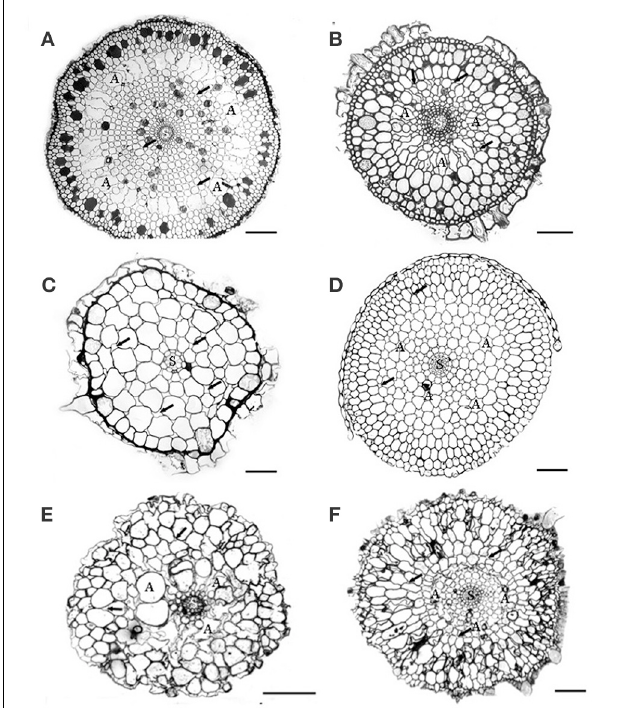
FIGURE 1 | Cross-sections of 6 Australian seagrasses. (modified from Cambridge et al., 2012) (A) Cymodocea sp.: The epidermis is distinct. Hypodermis with thickened walled cells. Outer cortex with 3–4 layers of large cells containing tannin substances. Middle cortex with many regular large lacunae (A). Small intercellular spaces (arrows) occur in the inner cortical tissue. The stele is distinct. Scale bar = 100 μ m. (B) Syringodium isoetifolium : Epidermal cells large, with tannin substances. Hypodermal cells small with thickened walls. Outer cortex with 3–4 layers of large cells, middle cortex with many developing regular large lacunae (A). Small air spaces (arrows) occur in both middle and inner cortical tissue. The stele (S) is distinct. Scale bar = 100 μ m. (C) Halodule uninervis : Epidermal cells large. Small hypodermal cells with thicken walled. Cortex does not have distinct regions and consists of 5–6 layers of cortical cells with the outer ones being the largest. Distinct intercellular spaces occur throughout the cortical tissues. The central stele (s) is small. Scale bar = 100 μ m. (D) Halophila ovalis : This section was taken from the basal portion of the root, where root hairs were absent. Epidermal cells small, hypodermal cells with thickened walls. Distinct lacunae (A) occur in the mid cortex region. The intercellular spaces (arrows) occur in both middle and inner cortical tissues. The stele (S) is distinct. Scale bar = 150 μ m. (E) Posidonia australis : Branched root shown: cortical tissue only has about 8–10 cell layers, without distinct regions. Air lacunae (A) are developing. Few intercellular air spaces (arrows) are present. Scale bar = 100 μ m. In developing “white” roots, epidermal cells are distinct, 1–2 layers of hypodermis and many distinct air lacunae in the middle cortex. Scale bar = 100 μ m. (F) Amphibolis Antarctica : Both epidermis and hypodermis are distinct and contain tannin substances. The outer cortex has several layers of compact cells, without intercellular air spaces. The mid cortex has few developing lacunae (A). Few intercellular air spaces (arrows) also occur in the cortical cells. Scale bar = 100 μ